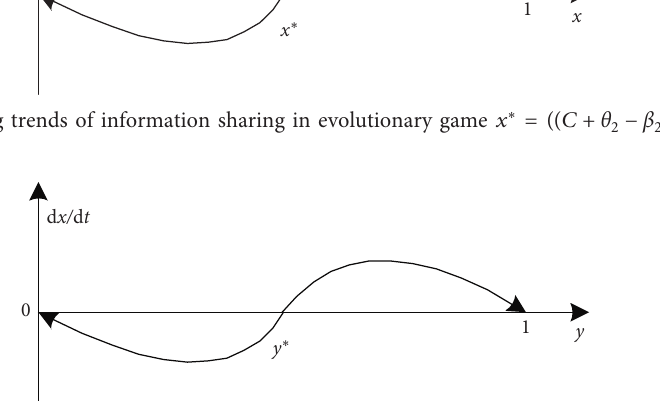
Figure 2: Changing trends of information sharing in evolutionary game y ∗ � (( C + θ